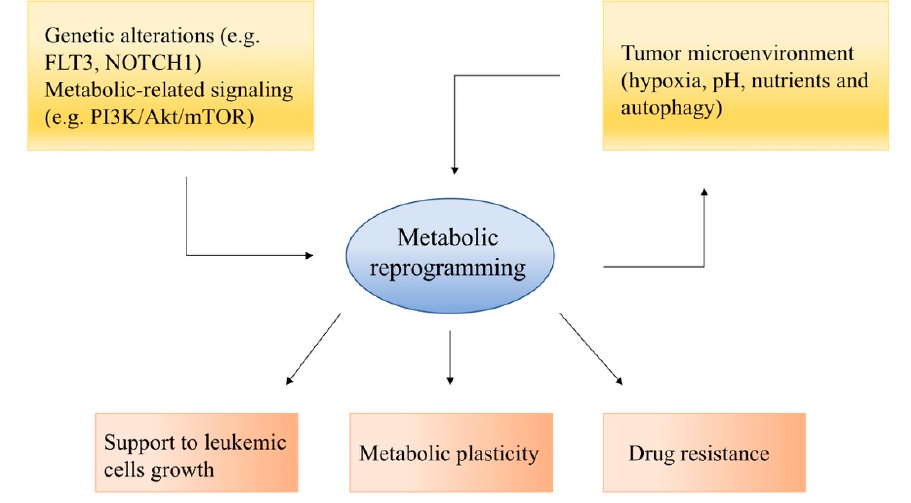
Figure 1. Metabolic rewiring in cancer cells is driven by multiple factors, involving both cytogenetic alterations, aberrant signaling and tumor microenvironment, and this eventually leads to molecular mechanisms that support cancer cell proliferation and therapy resistance.